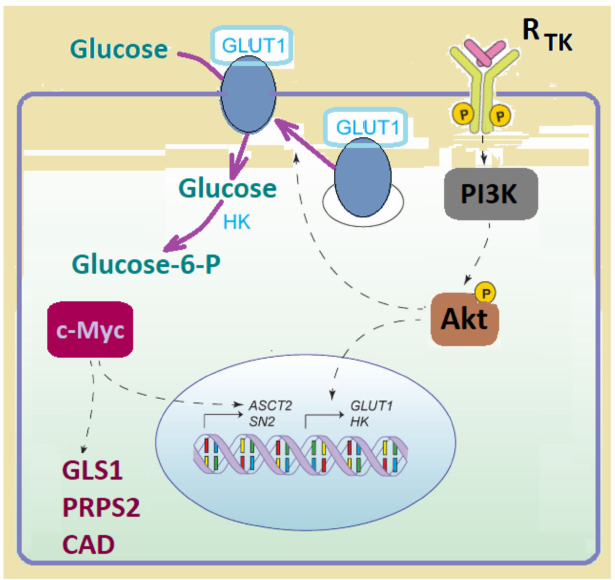
Figure 5. Aberrantly activated oncogenes deregulate the import of glucose through Glut1 into can- cer cells. The solid purple arrows depict the metabolites and metabolic reactions. Dashed arrows depict regulatory effects of signal transduction components. Legend: Glut1, glucose transporter 1; HK, hexokinase; GLS1, glutaminase 1; PRPS2, phosphoribosyl pyrophosphate synthetase 2; CAD, carbamoyl-phosphate synthetase 2; RTK, receptor for tyrosine kinase; ASCT2/SN2, glutamine trans- porter